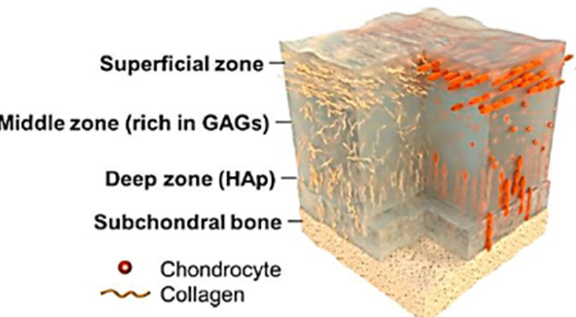
Figure 1. Illustration of the AC structure: superficial, transition and deep zones. Reproduced from [10].